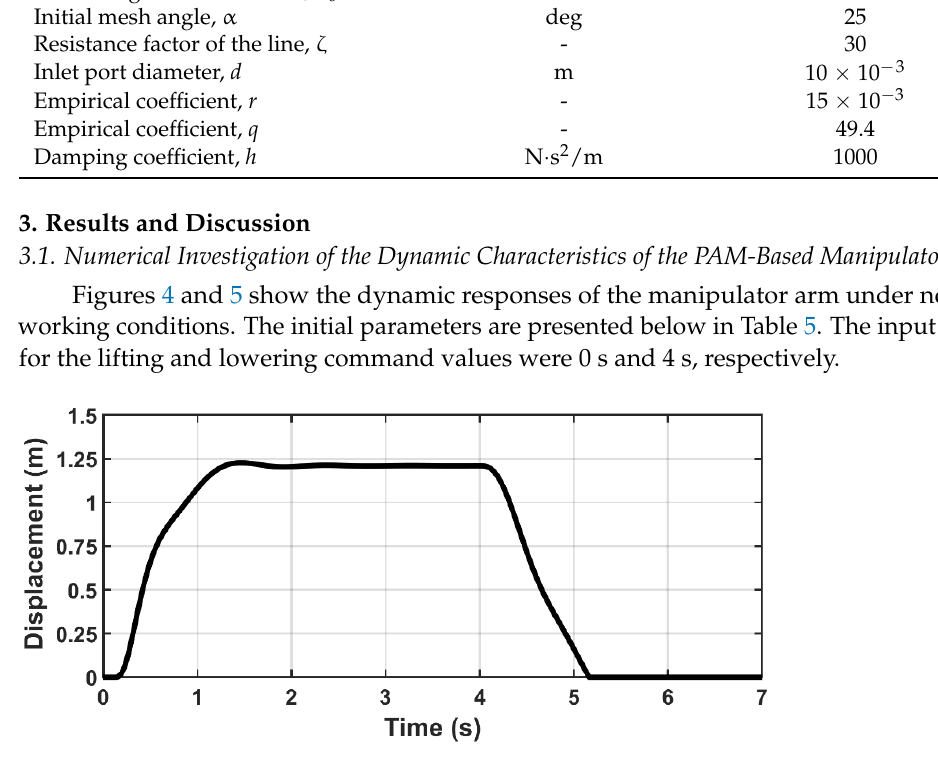
Figure 4. Dynamic responses of the loading arm displacement during lifting and lowering a load.